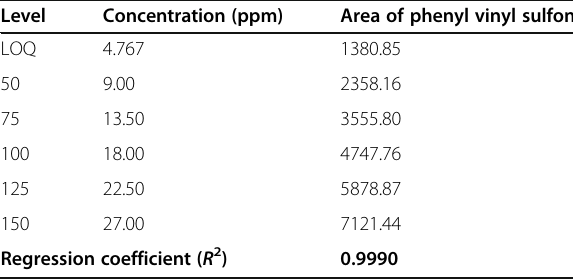
Table 3 Linearity for phenyl vinyl sulfone